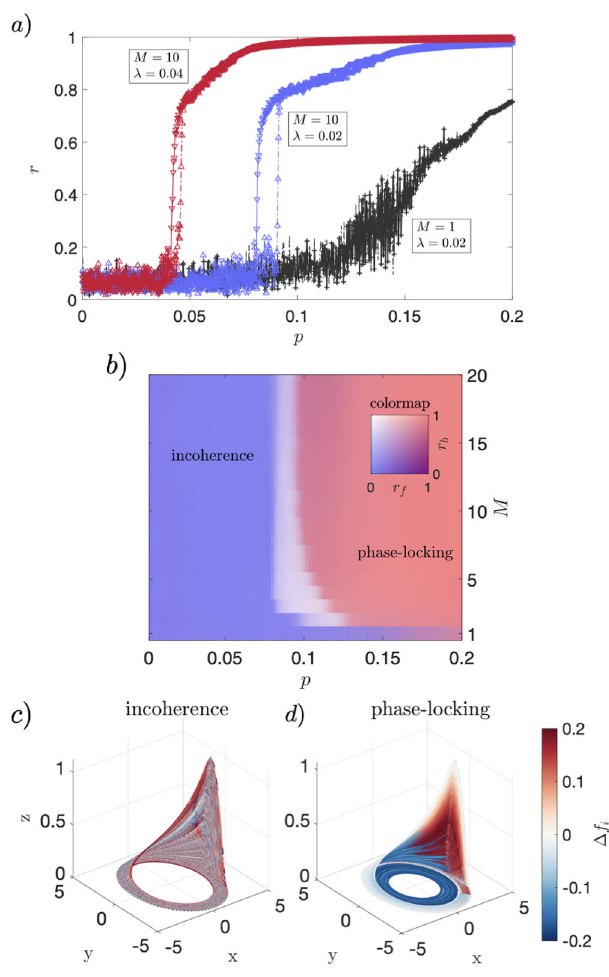
Fig. 4 Chaotic synchronization bombs. a Example of synchronization curves for several values of M and λ . It is observed that a hysteresis cycle appears when M > 1 and that lower (higher) values of λ translate into wider (more narrow) cycles and less (more) abrupt transitions. b Synchronization phase-space, depending on p and M for a fi xed λ = 0.02. Results are qualitatively similar to the ones found in Fig. 3b, although here the transitions are less abrupt and narrower than in the Kuramoto case, and the birth of hysteresis occurs for lower sampling (lower M ). c Evolution of the oscillators trajectories in the Rössler attractor for M = 10 and λ = 0.02 at two different p -steps, before and d after the forward synchronization transition. The color bar corresponds to the frequency of the oscillator relative to the mean. Equation (8) is numerically integrated using Heun ’ s method, with dt = 0.05 and 10 3 time steps and temporal averages of r are taken at every 5 link